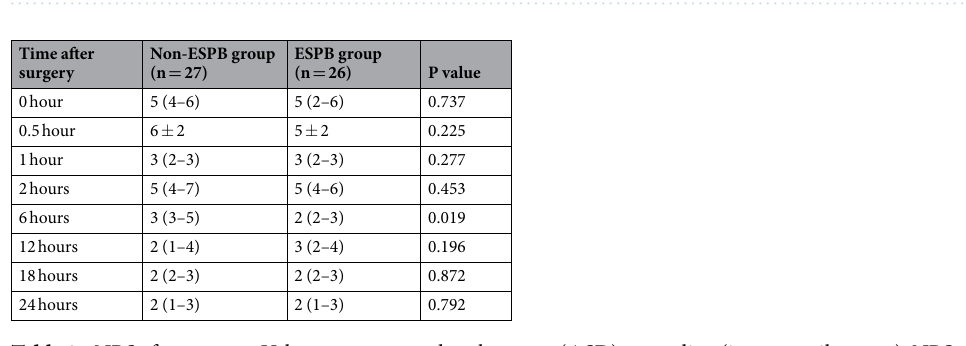
Table 3. NRS after surgery. Values are expressed as the mean ( ± SD) or median (interquartile range). NRS, Numeric rating score. Postoperative 0, 0.5, and 1 hour are measured in the recovery room.